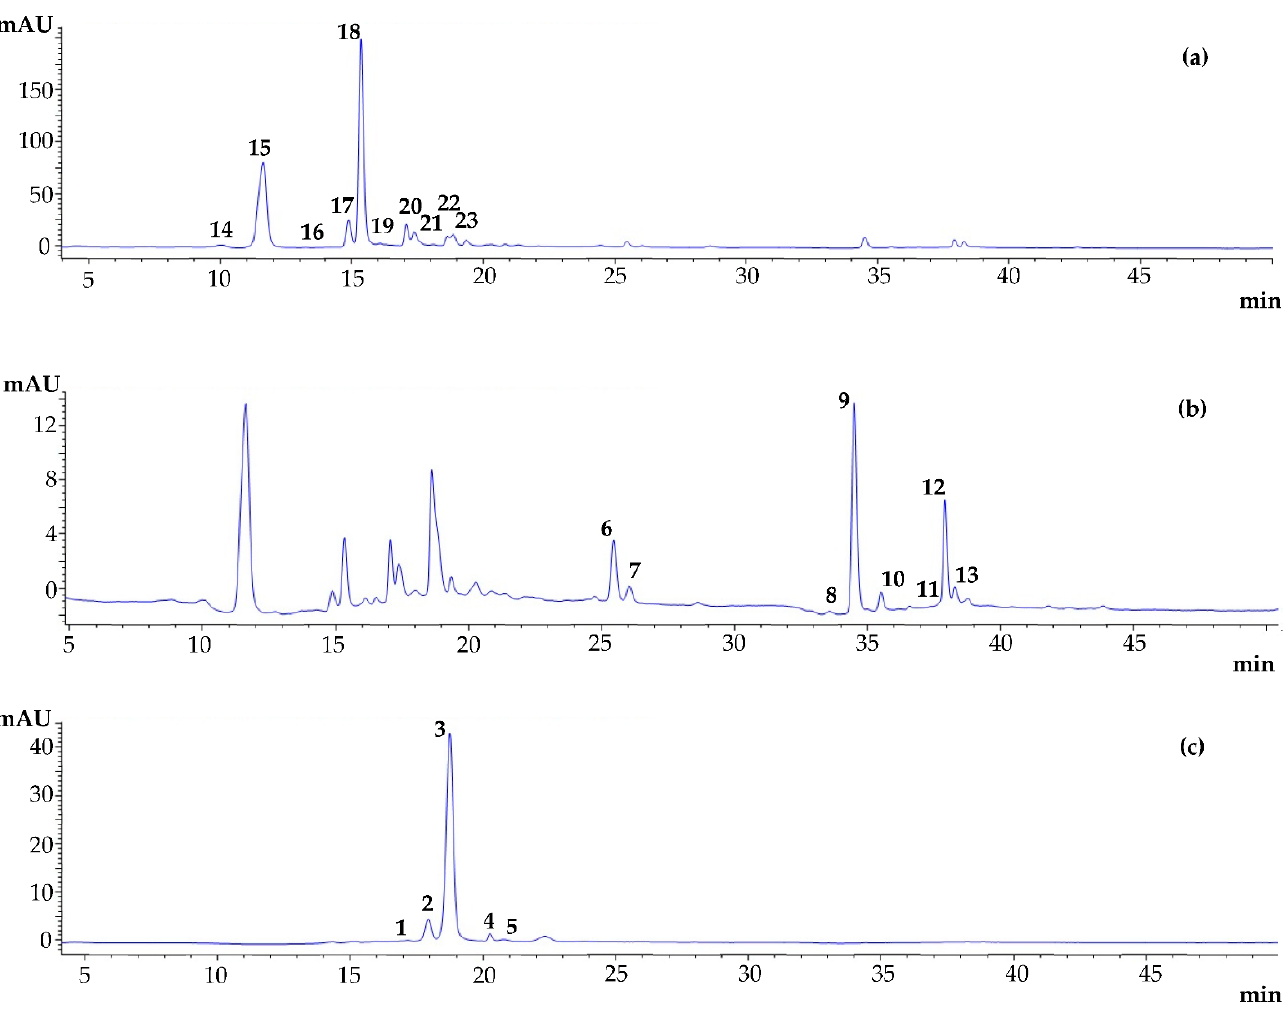
Figure 2. DAD chromatograms at ( a ) 320 nm, ( b ) 360 nm, and ( c ) 520 nm of cherry pulp (cv. Ferrovia) extract. Peaks number corresponds to the compounds listed in Table S1.